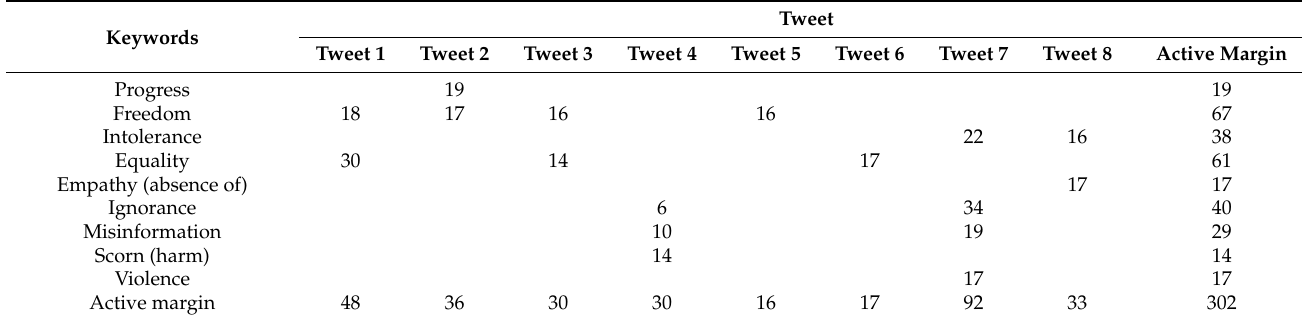
Table 7. Table of correspondences of absolute